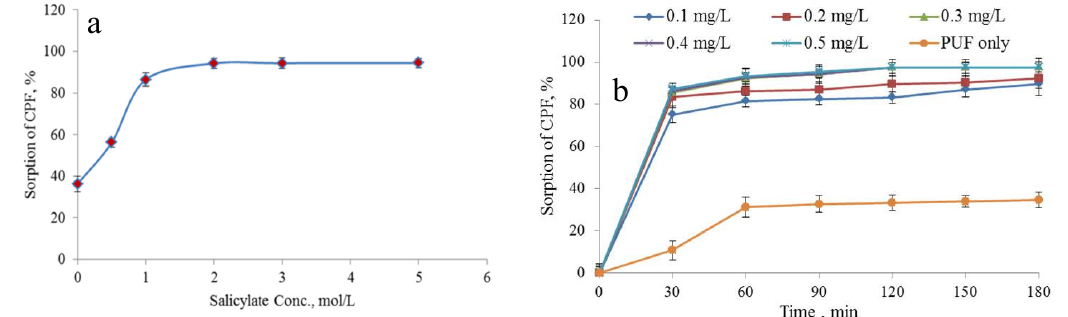
Figure 5. ( a ) Effect of salicylate concentration on the sorption of CPF by PUFS. Chlorpyrifos Figure5. ( a )E ff ectofsalicylateconcentrationonthesorptionofCPFbyPUFS.Chlorpyrifosconcentration concentration 1.0 ± 0.02 μg/L; ( b ) effect of white PUF and PUFS mass on CPF sorption percentage. 1.0 ± 0.02 µ g / L; ( b ) e ff ect of white PUF and PUFS mass on CPF sorption percentage. Experimental Experimental conditions: 25 mL volume of CPF; 10.0 ± 0.02 μg/L solution (aqueous phase), shaking conditions: 25 mL volume of CPF; 10.0 ± 0.02 µ g / L solution (aqueous phase), shaking time 180 min, time 180 min, agitation speed 100 rpm, temperature 25 °C. agitation speed 100 rpm, temperature 25 ◦